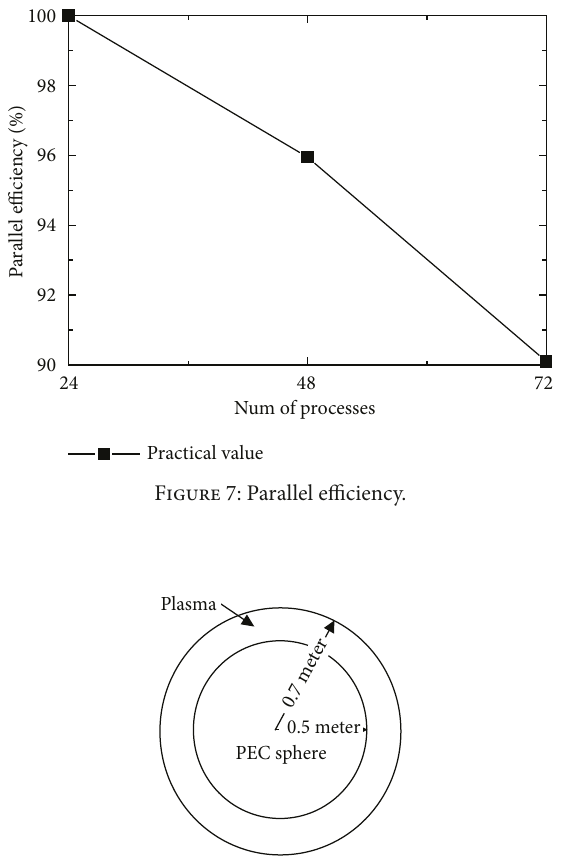
Figure 9: Monostatic RCS of the plasma-coated PEC sphere.